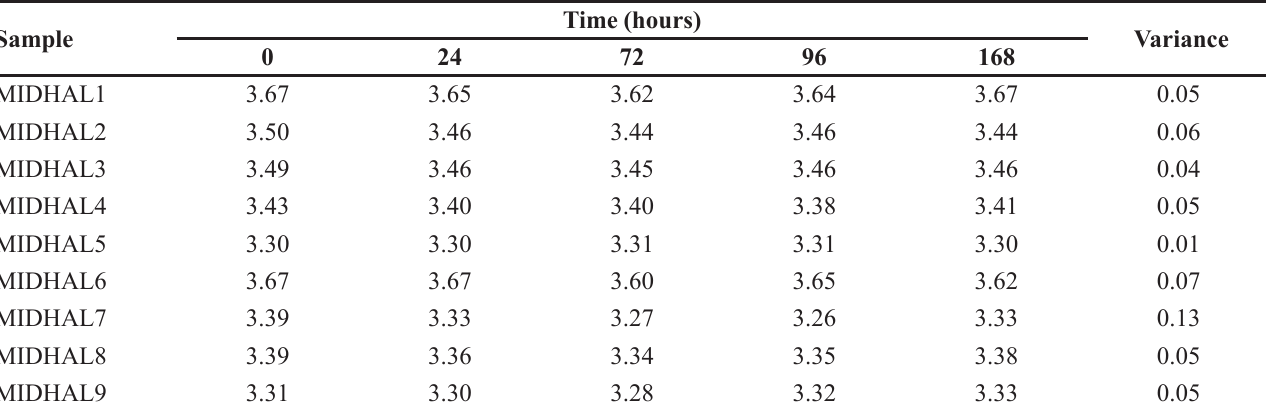
TABLE III - pH determinations in function of the time for the midazolam/haloperidol admixtures